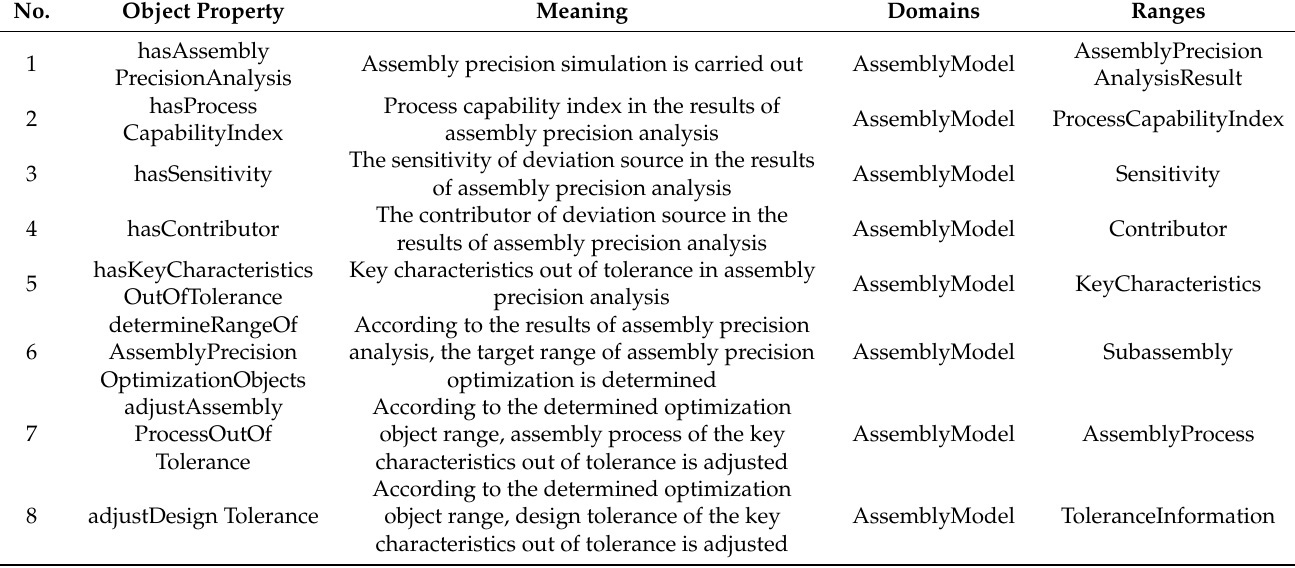
Table 1. Object properties in the assembly precision optimization ontology .